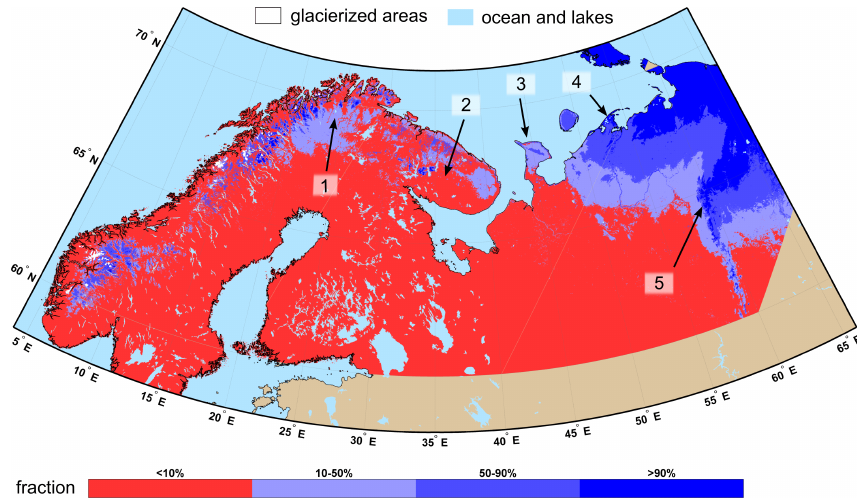
Figure 8. Fraction of model realizations with MAGT < 0 ◦ C inferred from the statistical modeling. Permafrost zonation corresponding to continuous ( > 90% of all realizations MAGT < 0 ◦ C), discontinuous (50–90%) and sporadic (10–50%) permafrost. 1: Finnmarksvidda; 2: Kola Peninsula; 3: Kanin Peninsula; 4: mouth of the Pechora River; 5: Ural Mountains. Glacierized areas from Natural Earth (www.